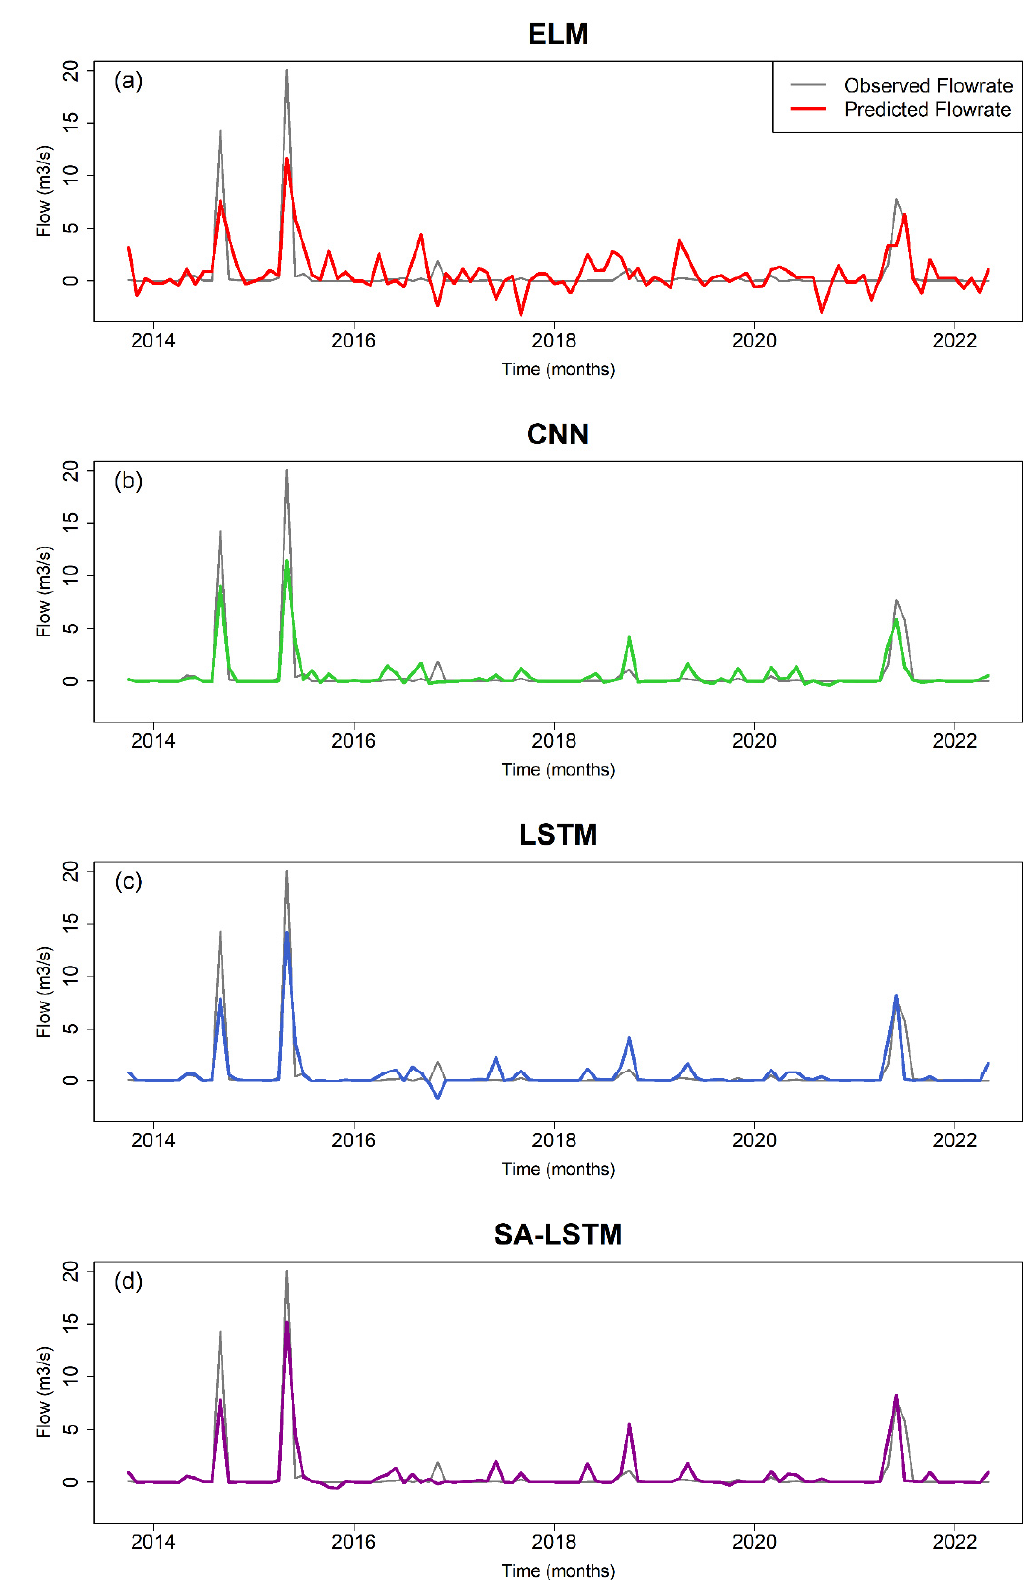
Figure 5. Observed vs. simulated flowrates by the investigated models during the testing period. During the testing period, the streamflow monitoring station at the headwaters of the Texas Colorado River recorded 35 dry months (no-flow), which is equivalent of 34% of the testing period. Additionally, three relatively large flooding events (greater than 5 cubic meters per second) were recorded that were greater than the highest previously rec- orded flood at the station of interest. Given the limitation of data-driven models in pre- dicting beyond the range of training data, the first two large flooding events were